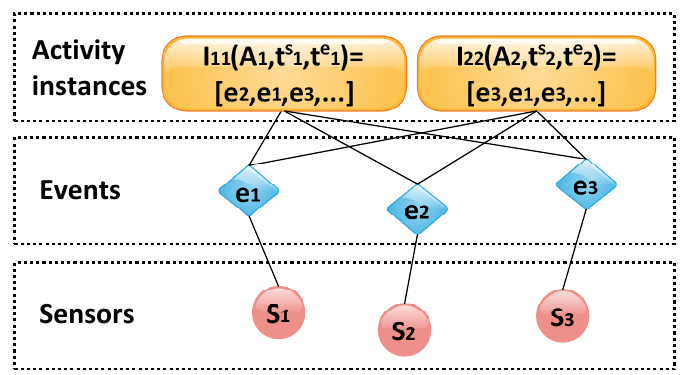
Figure 2. Example of activities and relevant subdivision into actions and observations, in connection with related